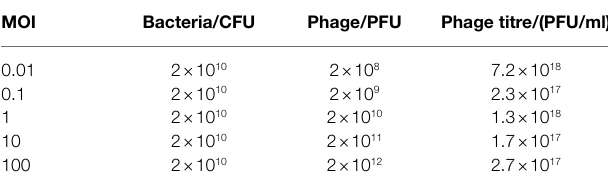
TABLE 2 | Host range of phage vB_KpnS_MK54. TABLE 3 | Determination of MOI of phage